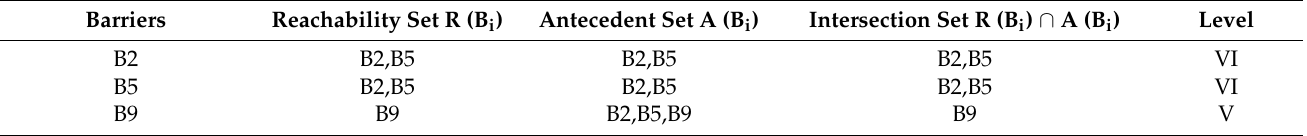
Table A5. Level partition iteration V &